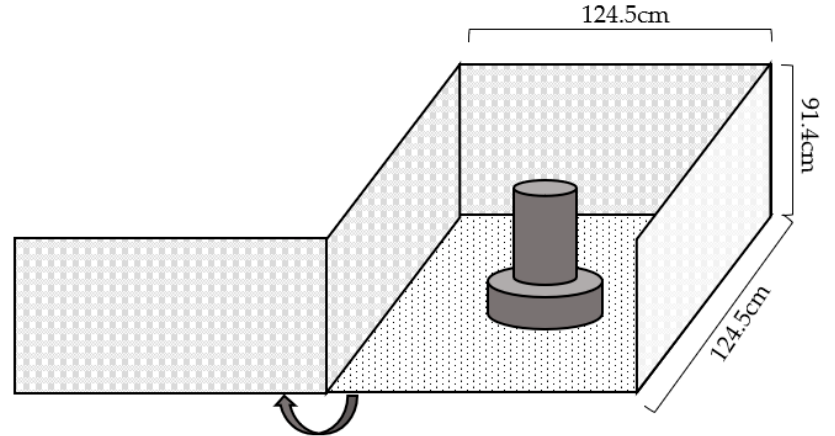
Figure 3. Diagram of the attention bias (AB) arena used in Experiments 1 and 2. A familiar feeder